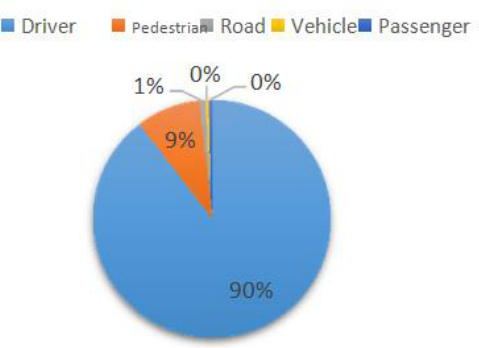
Figure 3. The Elements that Cause Traffic Accidents